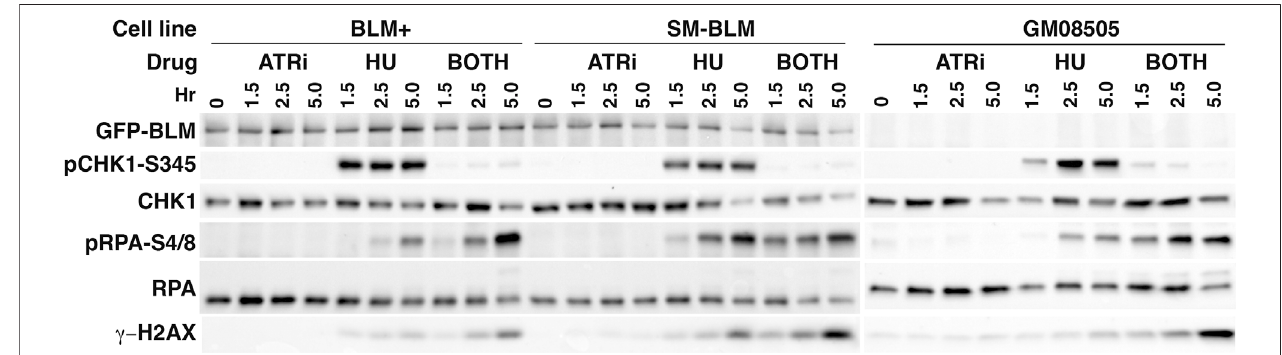
FIGURE 4 | CHK1 phosphorylation is normal in SM-BLM cells. BLM+, SM-BLM, and BLM-de fi cient GM08505 cells were treated with 2 mM HU for 1.5, 2.5, and 5 horleftuntreated. Celllysateswereprepared andanalyzed byWestern blotwithantibodiestotheindicatedproteins. ProteinsintheBLM+andSM-BLMlysateswere separated by SDS-PAGE through Bio-Rad Criterion 10% acrylamide gels and proteins in the GM08505 lysates were separated through Bio-Rad 4% – 15% acrylamide mini-PROTEAN